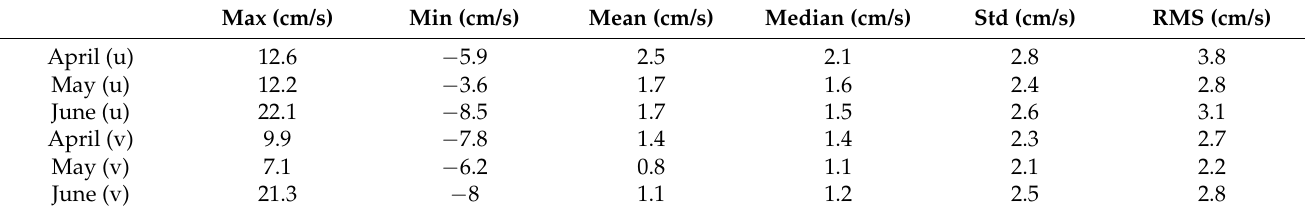
Table 12. Basic statistical properties of surface simulated zonal (u) and meridional (v) currents for the April–June